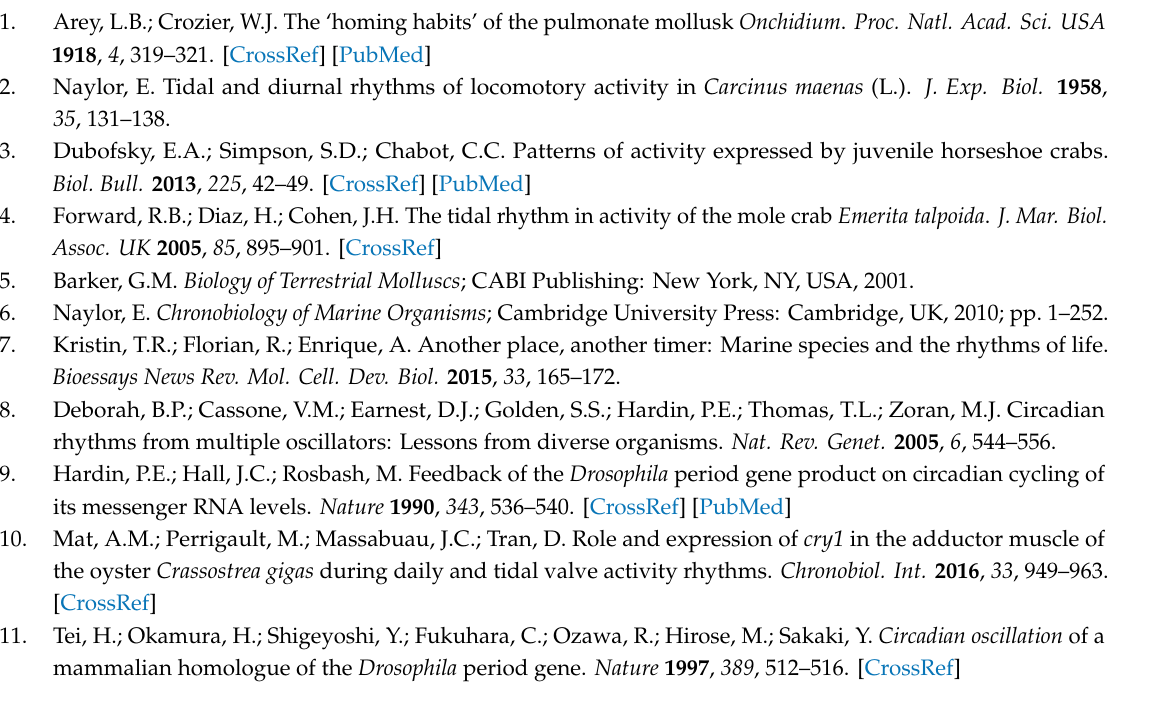
Figure S1: Phylogenetic tree of CRY family proteins, Figure S2: Phylogenetic tree of PERIOD family proteins, Table S1: Accession numbers for